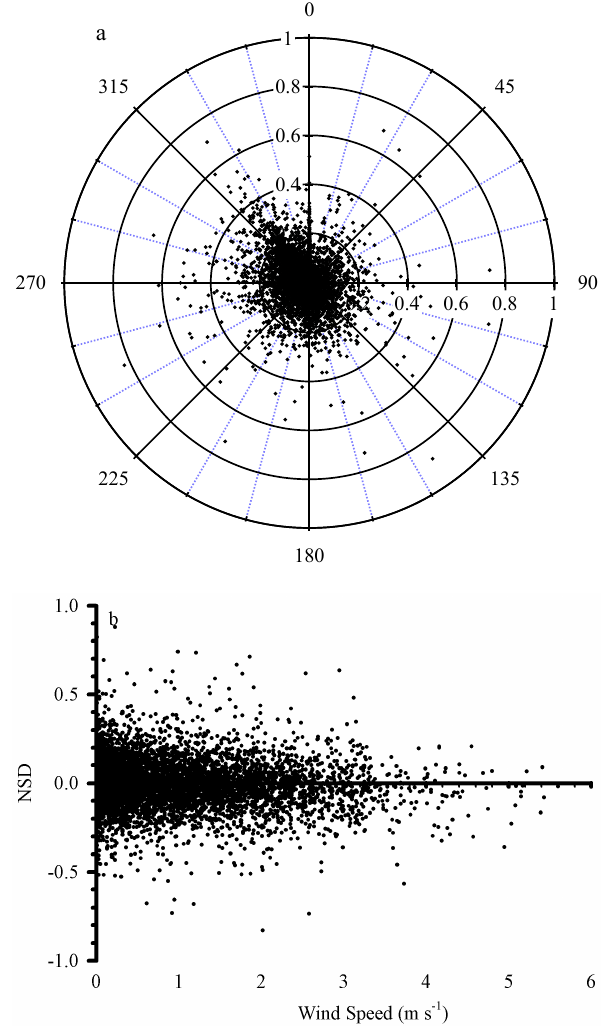
Fig. 2. (a) A plot of NSD with wind direction (North represented by 0 degree). (b) A scatter plot of NSD with wind